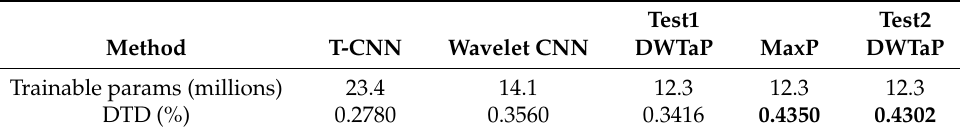
Table 8. Performance evaluation and comparison with other methods indicated as accuracy (%)—DTD